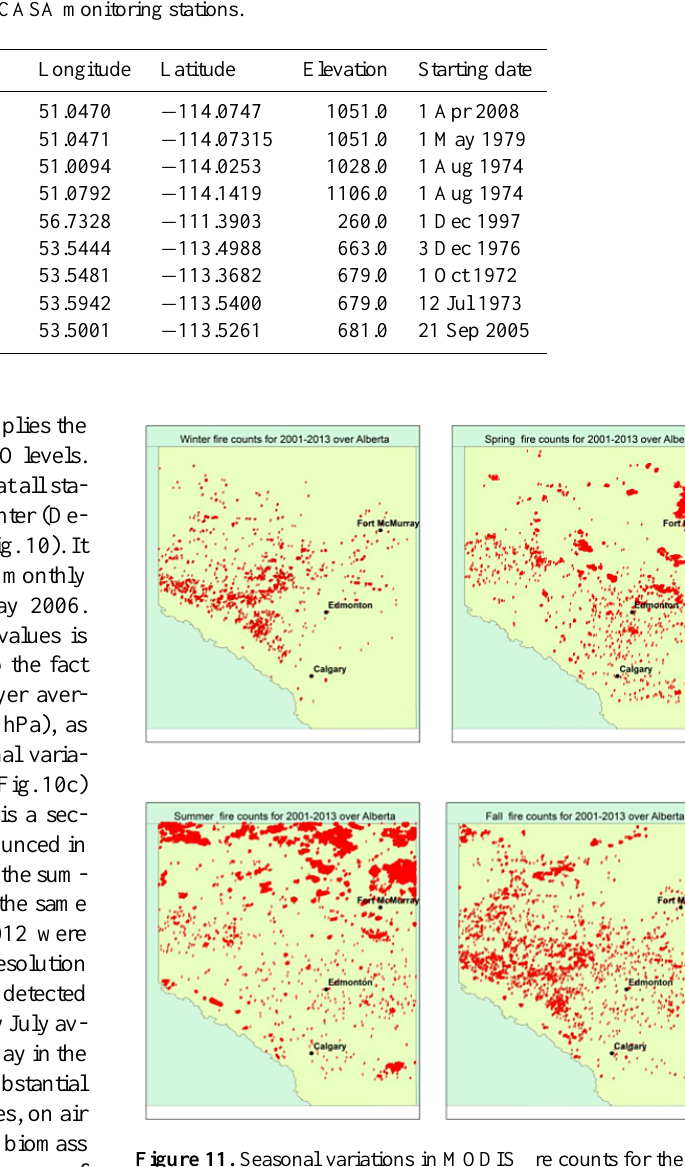
Figure 11. Seasonal variations in MODIS fire counts for the study period (2001–2013) over